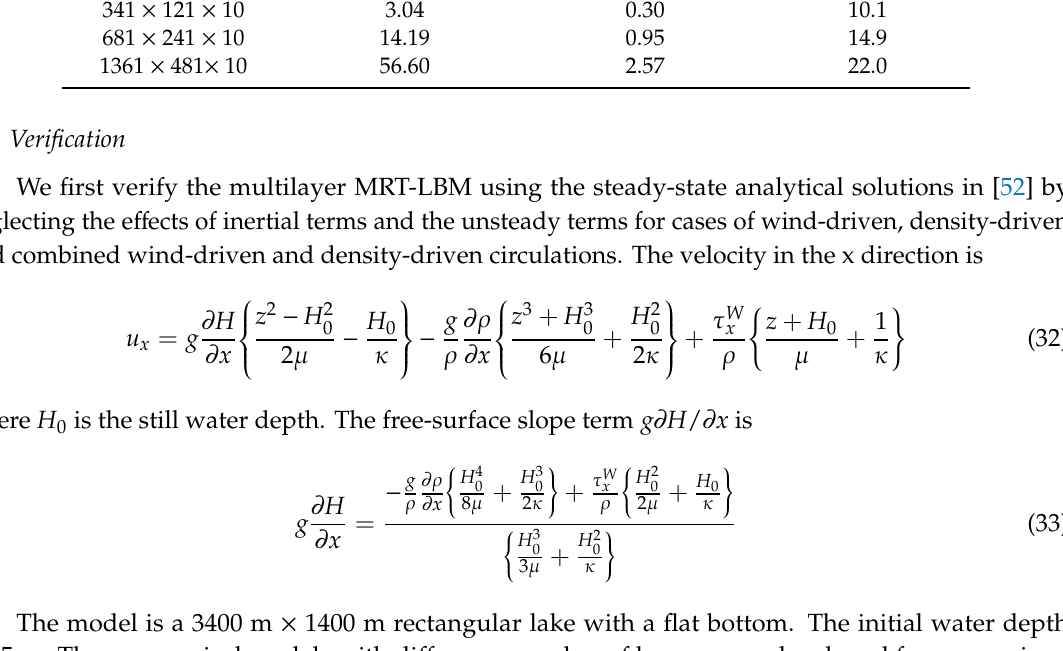
Table 1. The grid size, execution time per time step and speedup for the graphics processing unit (GPU) over a single core of the central processing unit (CPU) in MATLAB. CPU Speedup Grid Size Execution Time per Time Step